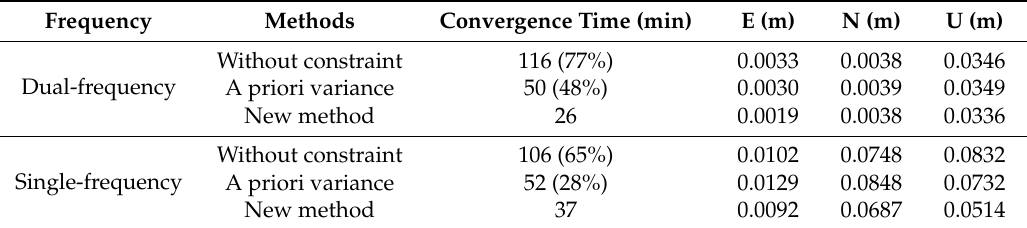
Figure 4. Static positioning errors (a,b), number of satellites, PDOP (c,d), weight factors (e,f) of dual-frequency RT PPP by station ANRK ( a,c,e ) and single-frequency RT PPP by station METG ( b,d,f ). Table 3. Static RT PPP for three processing methods.